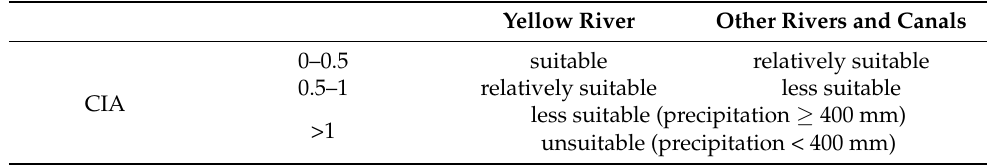
Table 1. WRSA discriminant matrix based on CIA and precipitation.